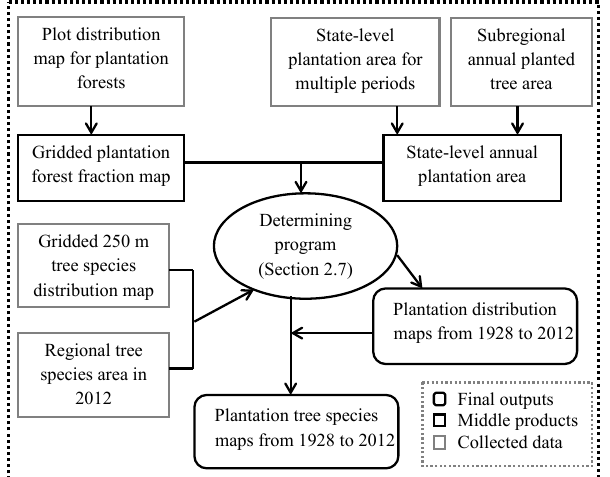
Figure 1. The workflow of overall processes in the generation of gridded (8km × 8km) plantation distribution and tree species maps from 1928–2012.